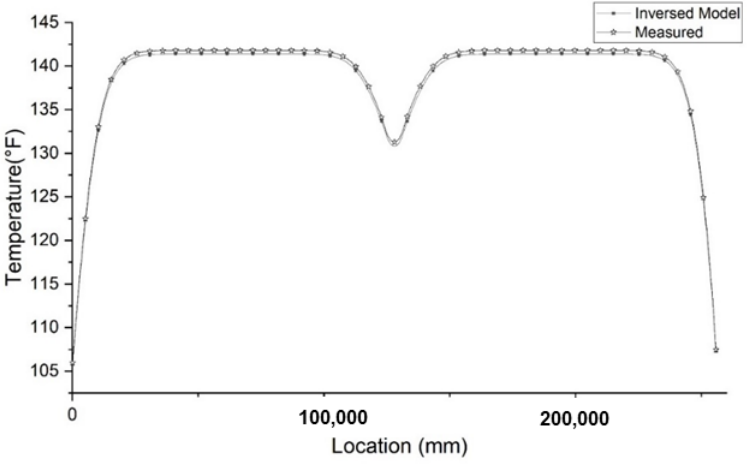
Figure 7. Comparison of measured temperature and inverse modeling for the necking defect.